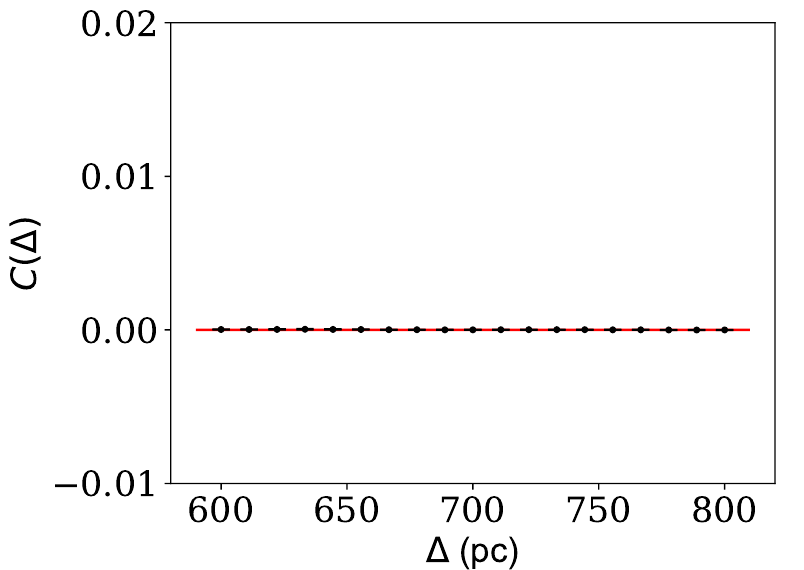
Figure 1. We use the hydrodynamic simulations of the Eagle project and select a halo of mass 10 9 M (cid:12) at zero redshift. We estimate the DM mass density across the halo and use that to find the two-point correlations C ( ∆ ) between DM mass density fluctuations as a function of the distance between the position of mass densities ∆ . We observe no statistically significant correlation. The statistical errors are estimated and shown in the